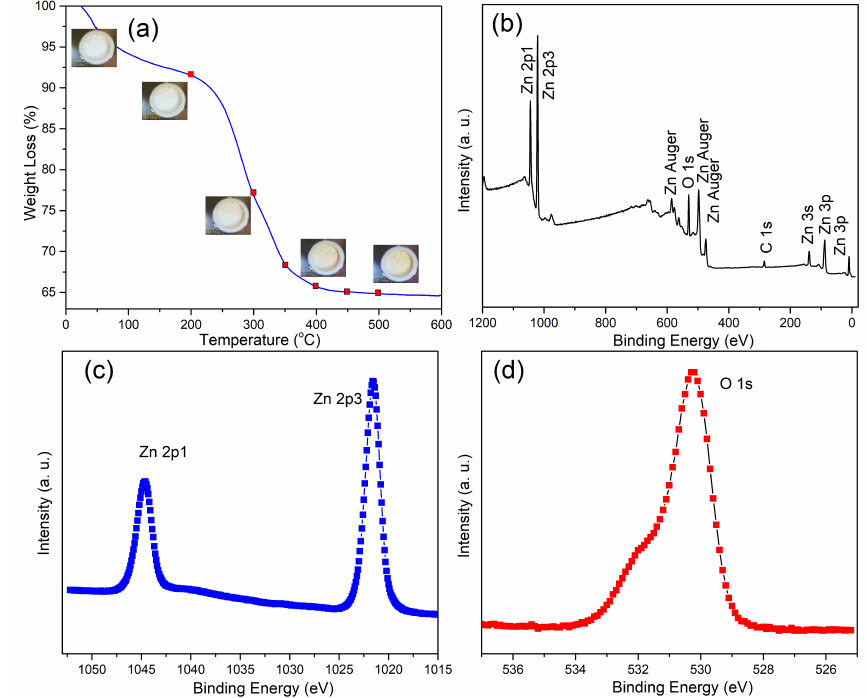
Figure 2. ( a ) TGA curves, ( b ) XPS survey spectra, and ( c ) Zn 2p and ( d ) O1s core-level spectra of hierarchical ZnO micro-spheres annealed at 400 ◦